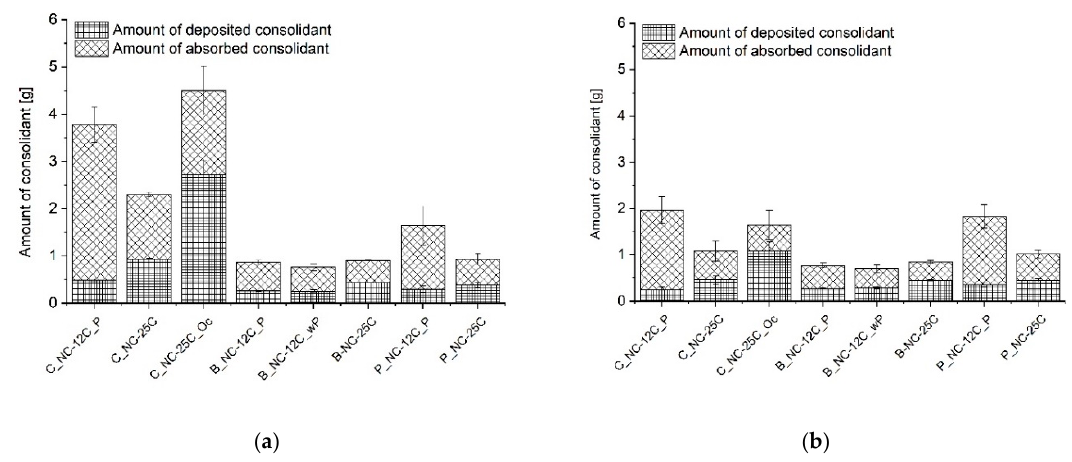
Figure 5. Comparison of the amount absorbed versus amount deposited inside ( a ) St. Margarethen Limestone and ( b ) Schlaitdorf Sandstone. For the calculation of the absorbed amount of consolidant, the weight of the stone in the initial dry state was subtracted from the weight after consolidation. To calculate the deposited amount of consolidant, the cured stone was weighed and subtracted by the weight of the initial dry state. The cured state corresponds to the mass recorded at the last day of outdoor curing, three weeks after the treatment application.